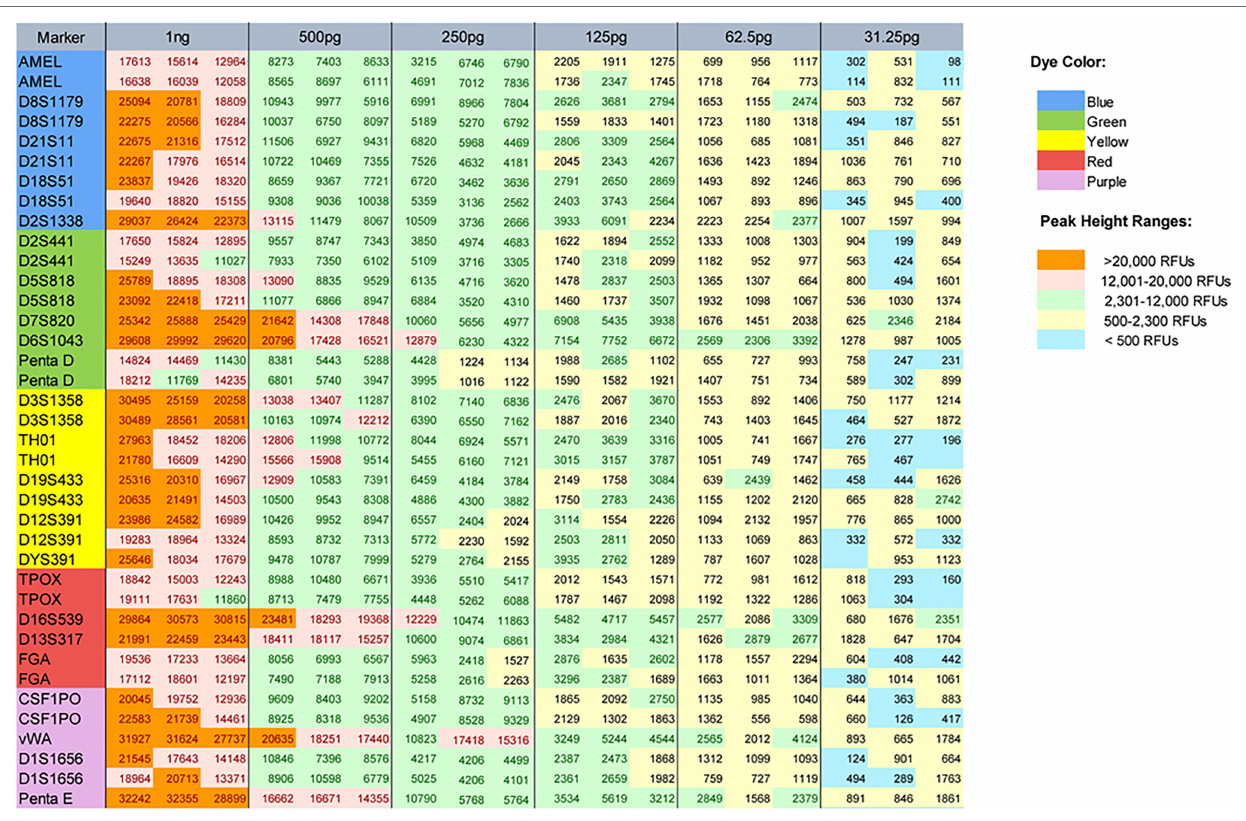
FIGURE 3 | Peak heights for male control DNA 9948 when the following template amounts were amplified: 1 ng, and 500, 250, 125, 62.5, and 31.25 pg. The peak height ranges were color-coded as follows: <500 RFUs (blue), 500–2,300 RFUs (yellow), 2,301–12,000 RFUs (green), 12,001–20,000 RFUs (pink), and >20,000 RFUs (orange). The dye color of each locus and color indicating each peak height range were shown as two legends on the right of the figure.